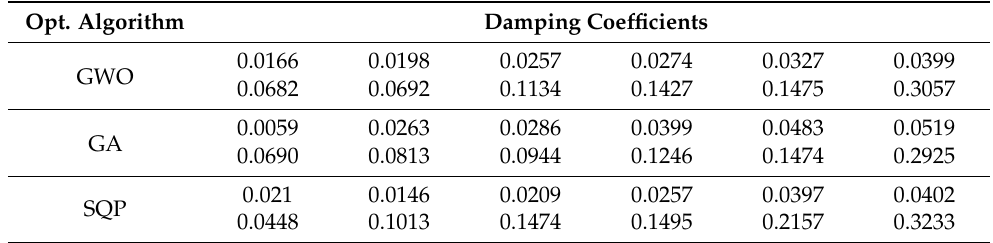
Table 5. Optimization results of damping coefficients (12-DOF model—shaking loads